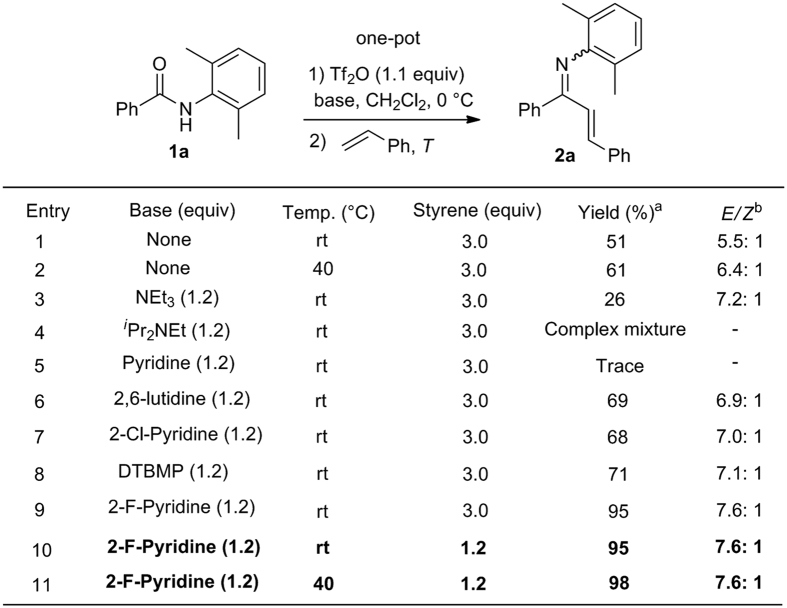
Optimization of the reaction conditions.aIsolated yield. bThe E/Z ratio of imine was determined by 1H NMR. Tf2O = trifluoromethanesulfonic anhydride. 2,6-lutidine = 2,6-dimethylpyridine. DTBMP = 2,6-di-tert-butyl-4-methylpyridine.